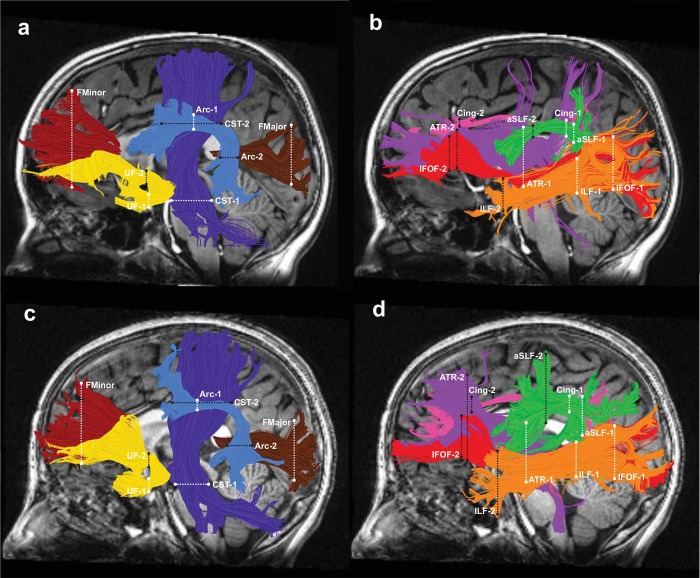
Tractography of 18 major cerebral white matter tracts.The left hemispheric cerebral tracts are displayed on mid-sagittal T1 images from a representative full term subject (a, b) and a representative preterm subject (c, d). Right hemisphere tract renderings not shown. Panels a and c illustrate the following tracts: Arcuate Fasciculus (Arc) = light blue; Corticospinal Tract (CST) = dark blue; Forceps Major (FMajor) = brown; Forceps Minor (FMinor) = dark red; Uncinate Fasciculus (UF) = yellow. Panels b and d illustrate the following tracts: Anterior Thalamic Radiation (ATR) = purple; Cingulum (Cing) = magenta; Inferior Fronto-occipital Fasciculus (IFOF) = red; Inferior Longitudinal Fasciculus (ILF) = orange; Anterior Superior Longitudinal Fasciculus (aSLF) = green. Dashed lines represent the location of the regions of interest (ROIs) used to isolate each cerebral tract; ROI 1, white; ROI 2, black.